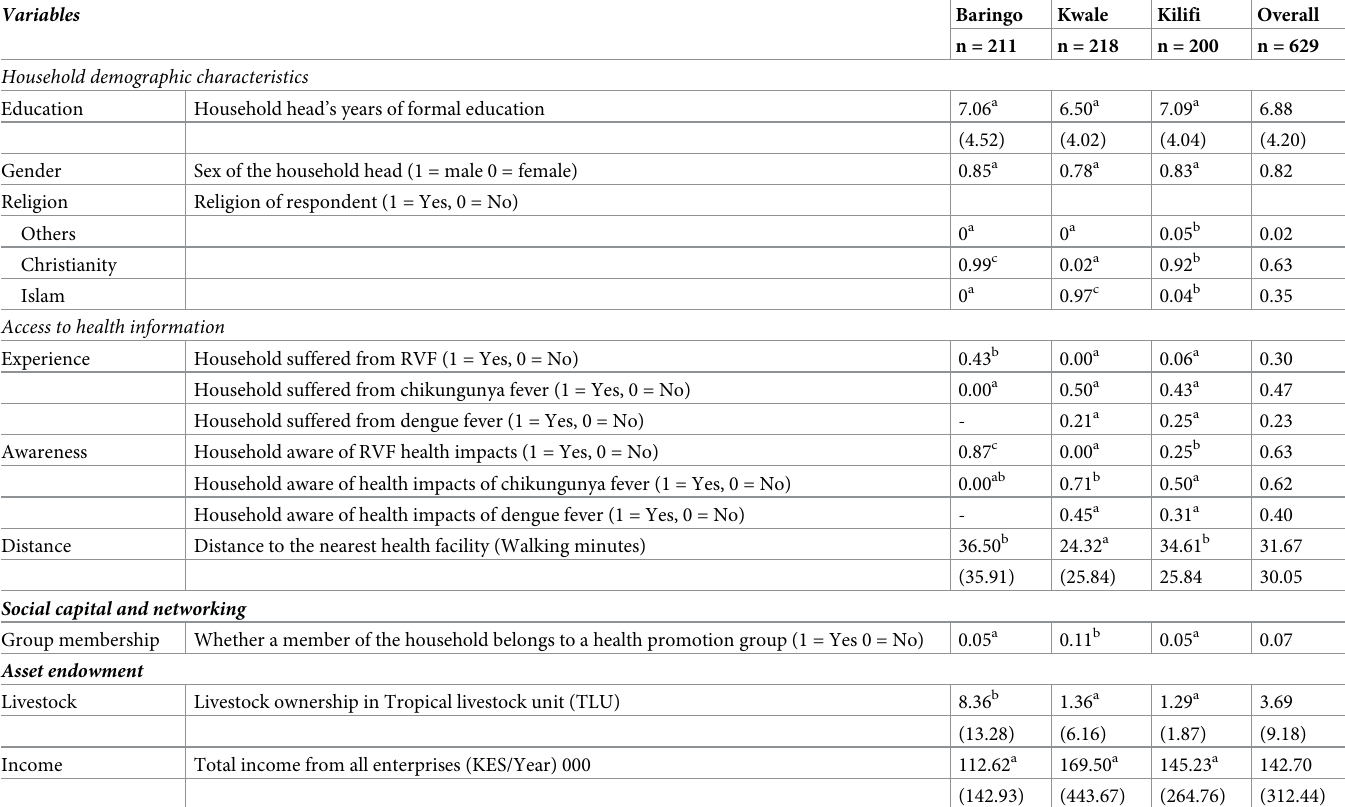
Table 1. Characteristics of livestock keepers in Kenya’s ADs Hotspots.